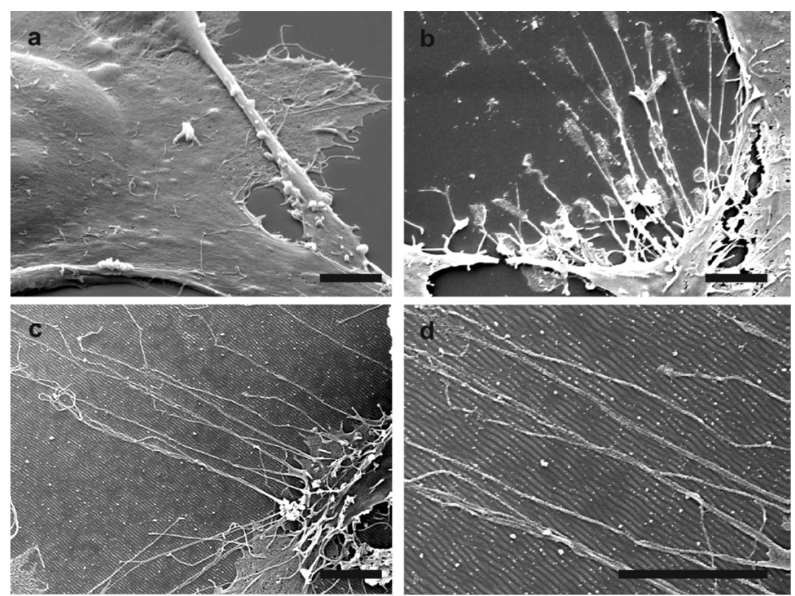
Figure 8. SEM images of MG-63 cells cultured on ( a ) polished Al 2 O 3 (0001), ( b ) nanorippled Al 2 O 3 (0001) with a periodicity of 24 nm, and ( c , d ) nanorippled Al 2 O 3 (0001) with a periodicity of 179 nm. Scale bars are 2 µm. Reprinted from Ref. [89] with permission from Elsevier.